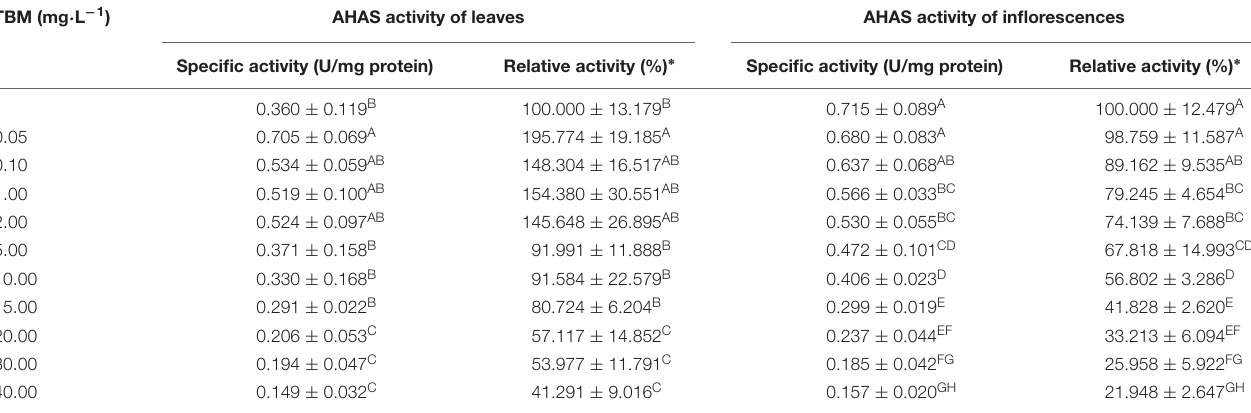
# Data in the table are expressed by mean ± SD, n = 6. Data followed by different superscript capital letter within same column means significant difference at P = 0.01 level. ∗ Relative activity of AHAS was determined as the percentage of absorbance value of each sample of TBM-treated plants and the corresponding sample of the control plants (treated with 0 mg · L -1 of TBM). TABLE 6 | Changes of AHAS activity in the mutant line K5 treated with different concentrations of tribenuron-methly (TBM) # .